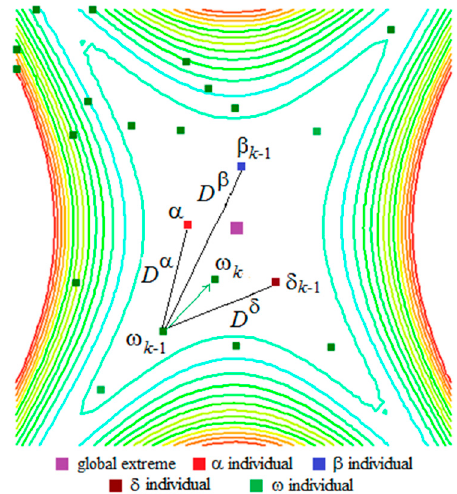
Figure 3. The determination of new position of ω individual.